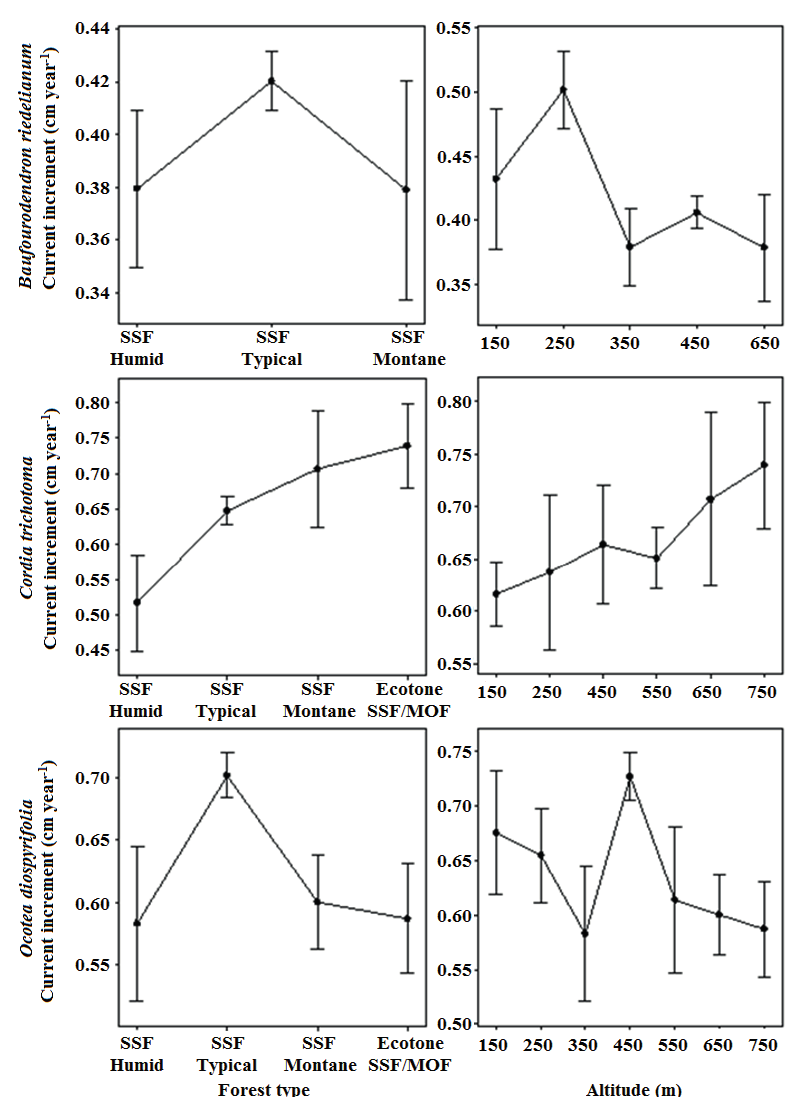
Figure 4 - Means for current increment in diameter (DBH ≥20cm) of Balfourodendron riedelianum , Cordia trichotoma and Ocotea diospyrifolia at altitude levels and forest types in the Iguaçu National Park; SSF - Seasonal Semideciduous Forest, MOF - Mixed Ombrophilous